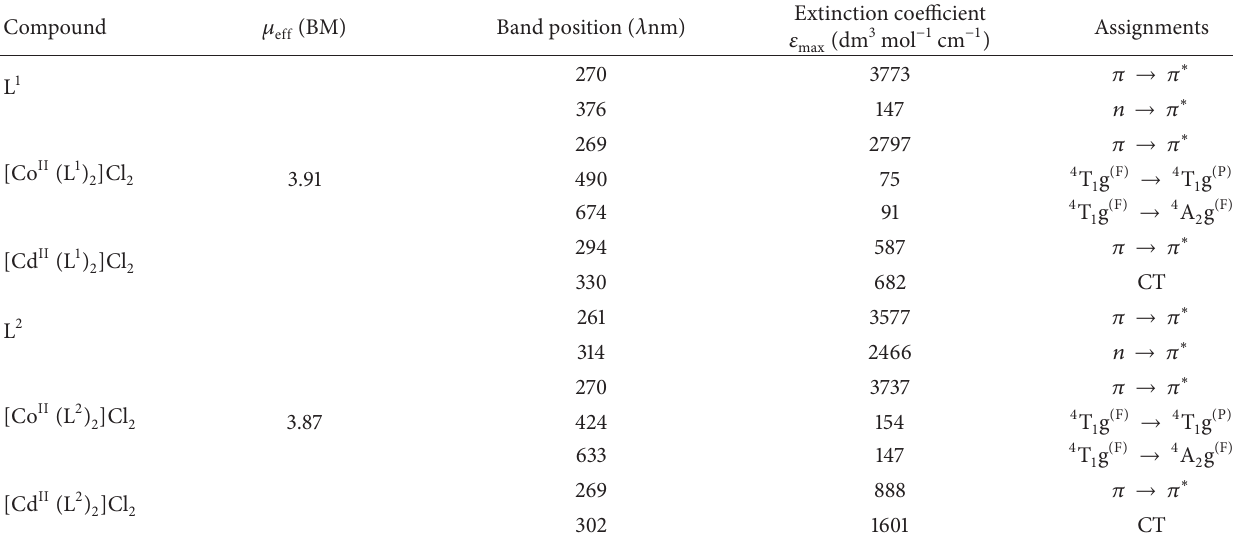
Table 3: U.V-Vis spectral data in DMSO solutions.